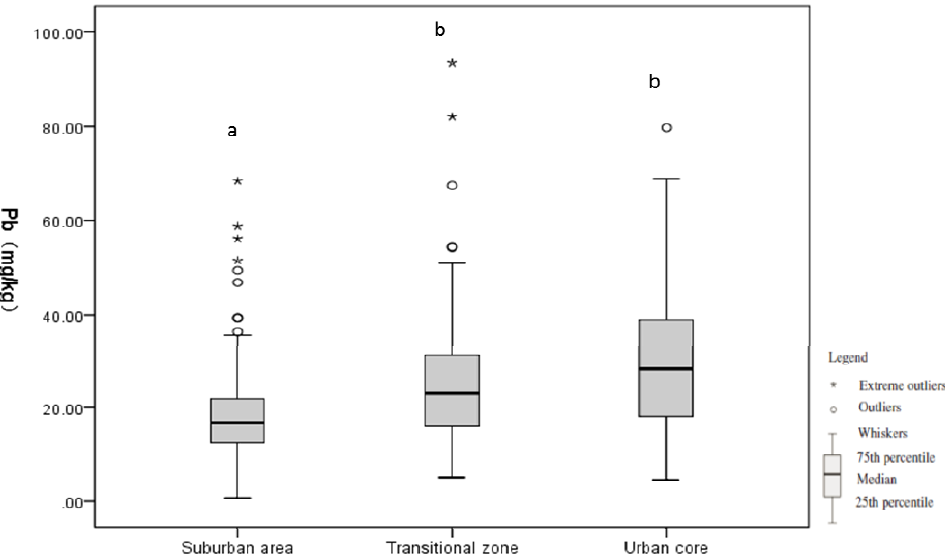
Figure 3. Box-and-whisker plots for soil Pb levels along the urbanization